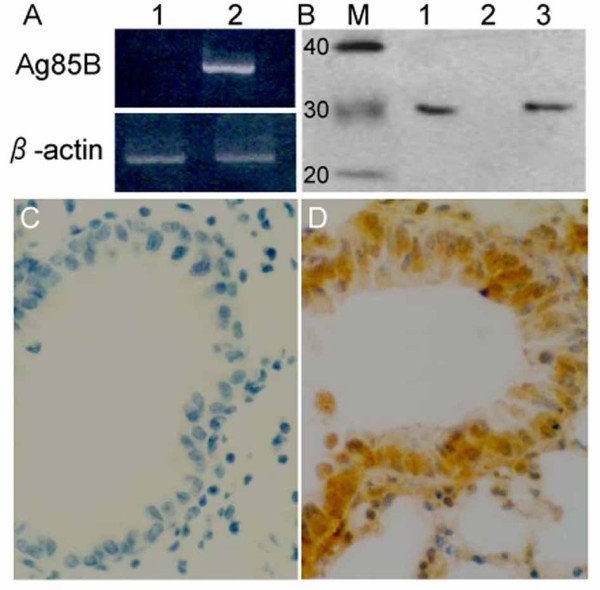
Ag85B expression in murine bronchial epithelial cells. A. Murine cells were transfected with pMG plasmids (Lane 1) or pMG-Ag85B plasmids (Lane 2). Ag85B mRNA (992 bp) expression was tested 36 hours after transfection by RT-PCR. B. As described in A, Western blotting was used to determine Ag85B protein expression in the supernatant of pMG-Ag85B transfected murine bronchial epithelial cells (Lane 1) and pMG transfected cells (Lane 2). The positive control was 100 ng purified Ag85B protein (Lane 3). C, D: Mice were intranasally immunized with 100 μg pMG (C) or pMG-Ag85B plasmids (D), with a booster dose 7 days after the initial immunization. Immunohistochemistry staining shows Ag85B protein expression in the lung 48 hours after the booster dose.